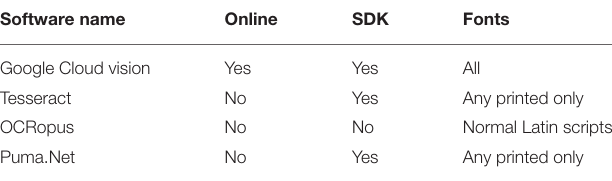
TABLE 3 | Comparison among various OCR